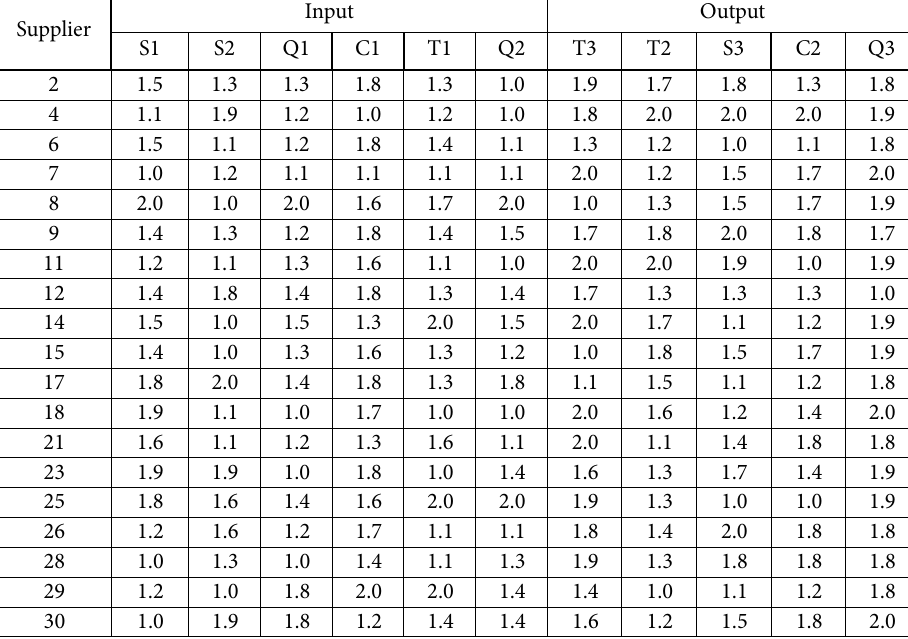
Table 10. Processed data of oxygen sensor for the DEA